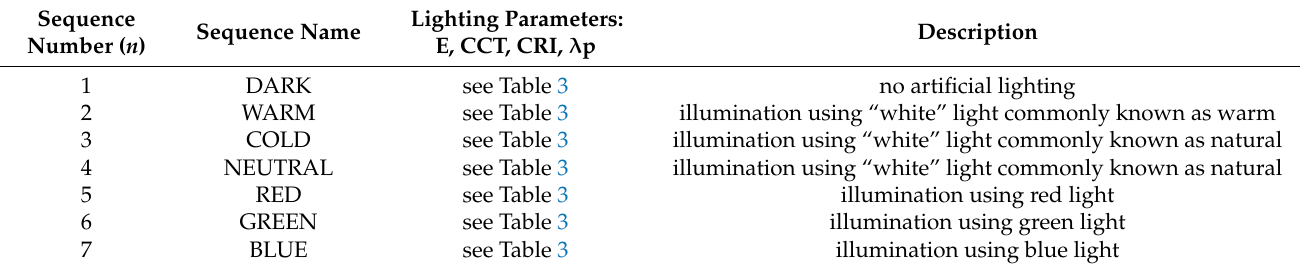
Table 2. Sequences of used lighting.